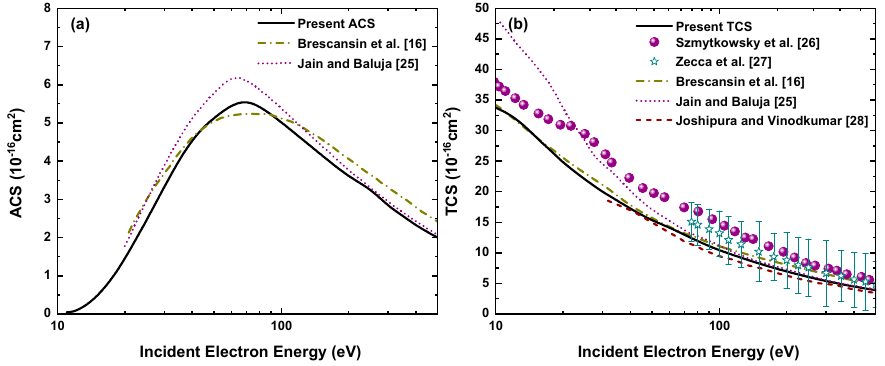
Figure 6. ( a ) Absorption cross sections and ( b ) total cross sections for electron − H 2 S elastic scattering as a function of incident electron energy.